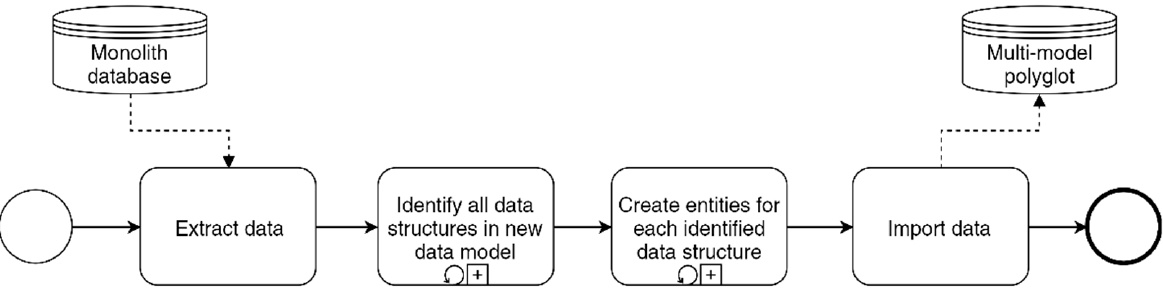
Figure 5. The proposed data transformation process.